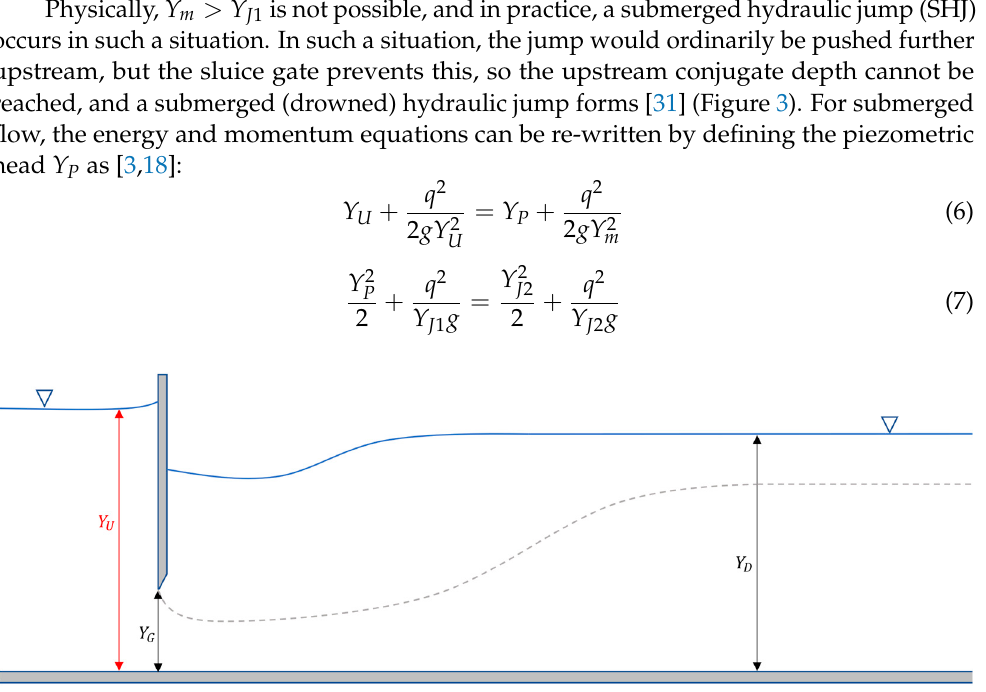
Figure 3. Submerged (drowned) hydraulic jump.